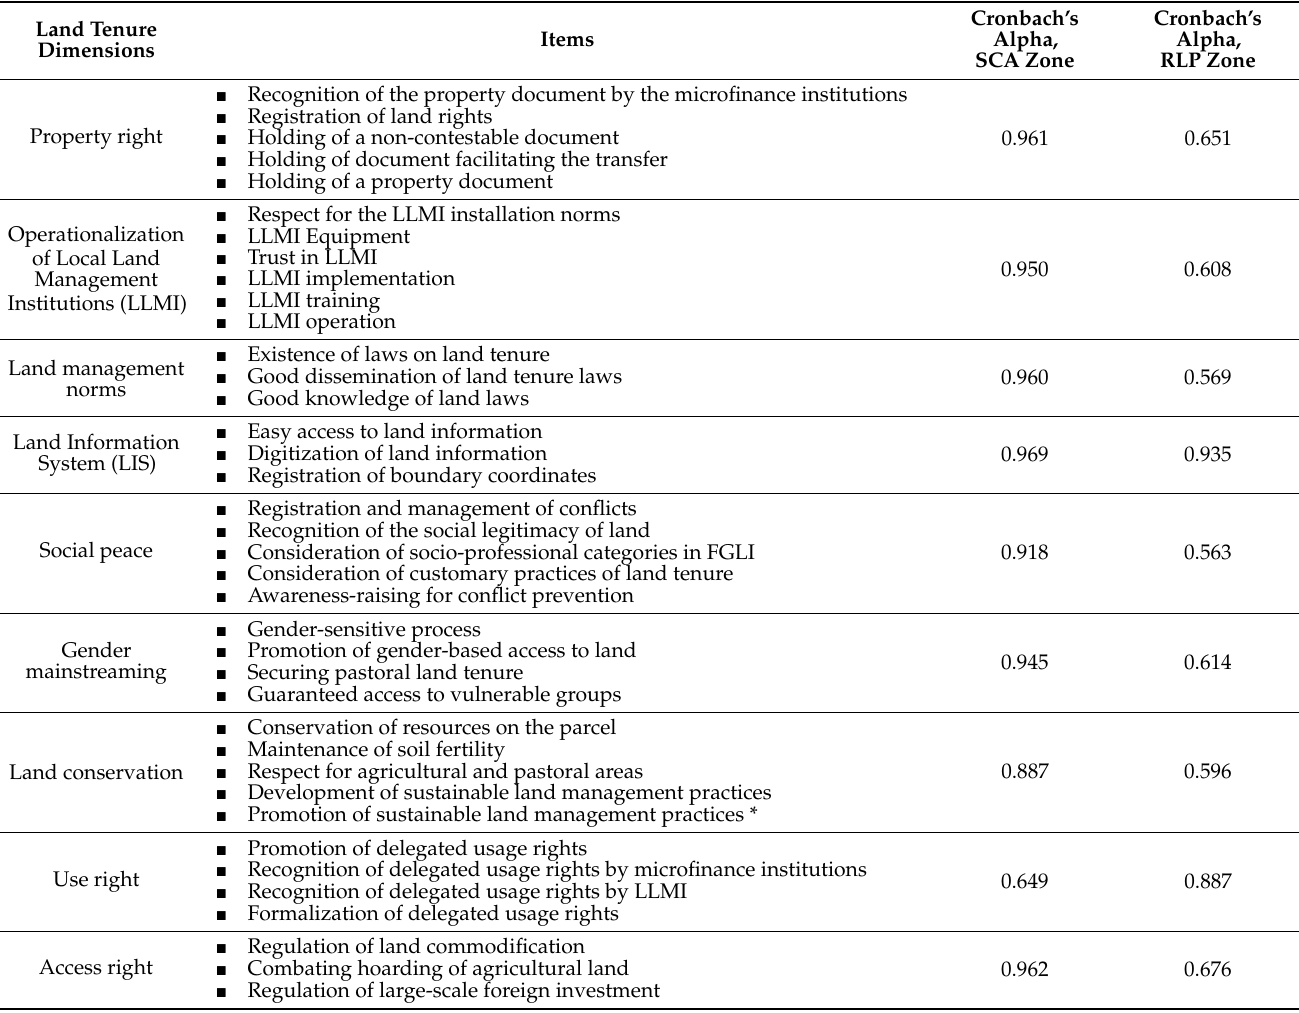
Table 3. Reliability of measurement